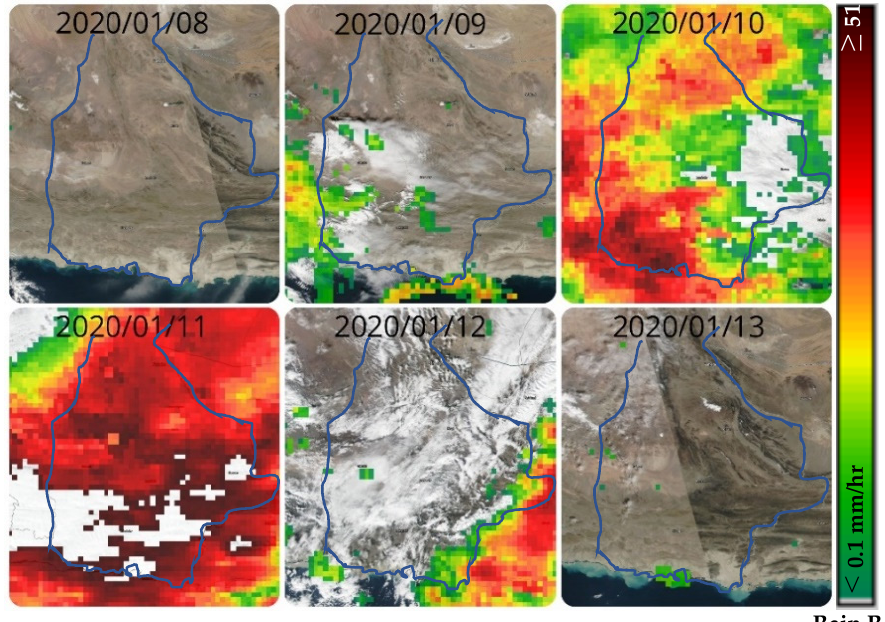
Figure 3. Rate of torrential precipitation in the Sistan and Baluchestan province over the period of six days from 8 January to 13 January, 2020. The maps were generated using the data provided by the authors of [37].